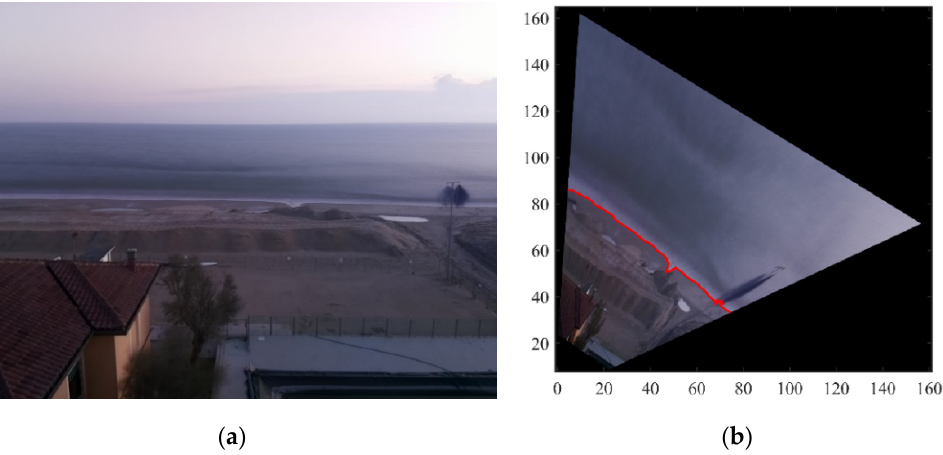
Figure A3. Example of shoreline detection: ( a ) Raw oblique image from VISTAE. ( b ) Rectified image, with the detected semi-automatic shoreline. The horizontal coordinates in panel ( b ) are in meters, and the origin is individuated by the camera position.